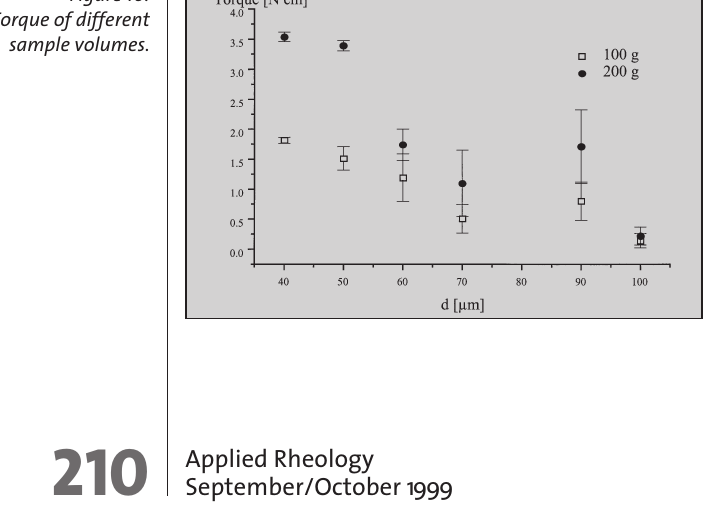
Figure 16: Torque of different sample